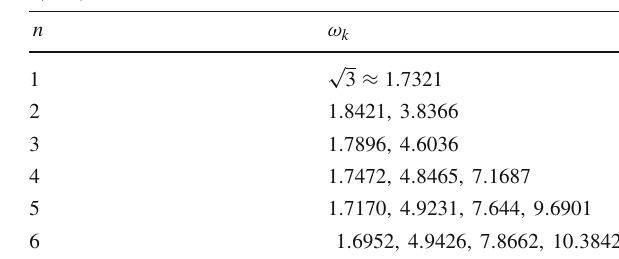
Table 1 Values of the discrete eigenfrequencies corresponding to n = 1 ,...,